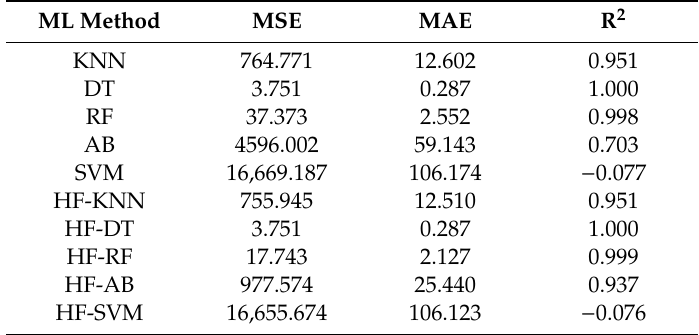
Table 8. Longitude regression results of training data.